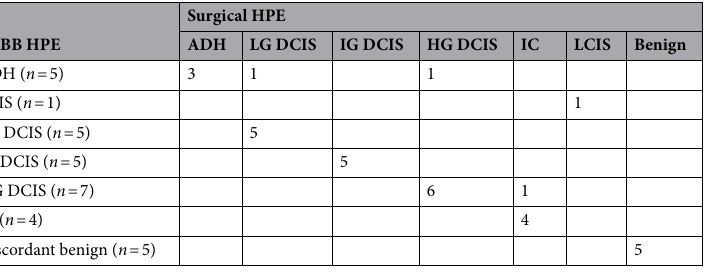
Table 4. Comparison of VABB HPE and Surgical HPE. * LG, IG, HG DCIS = Low, intermediate, high grade DCIS, IC = Invasive carcinoma.